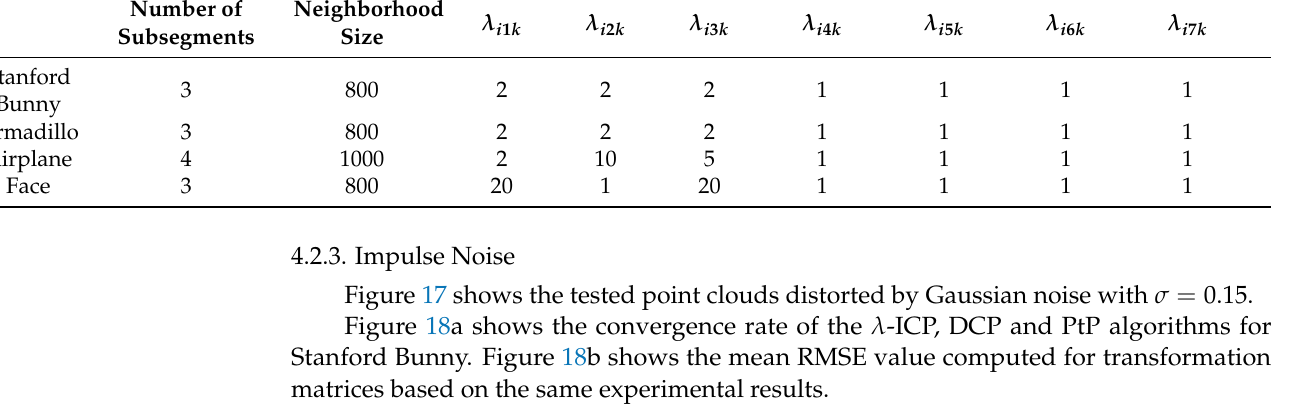
Table 3. Parameters of the λ -ICP algorithm for the case of Gaussian noise with σ = 0.15. Number of